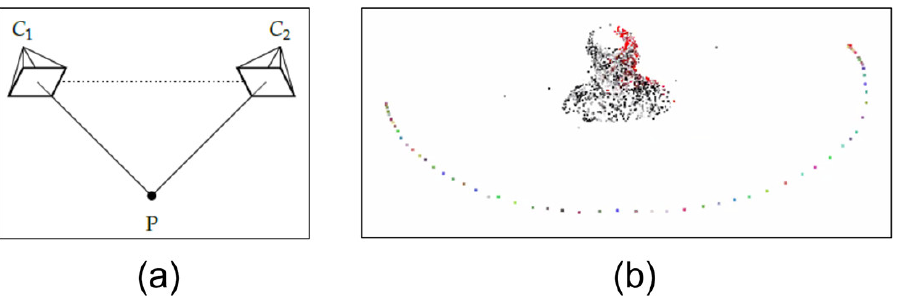
Figure 8. Illustration of the SfM technique: ( a ) representation of epipolar geometry; ( b ) result obtained from one of the mapped volunteers, showing the point cloud and the positioning of the cameras.